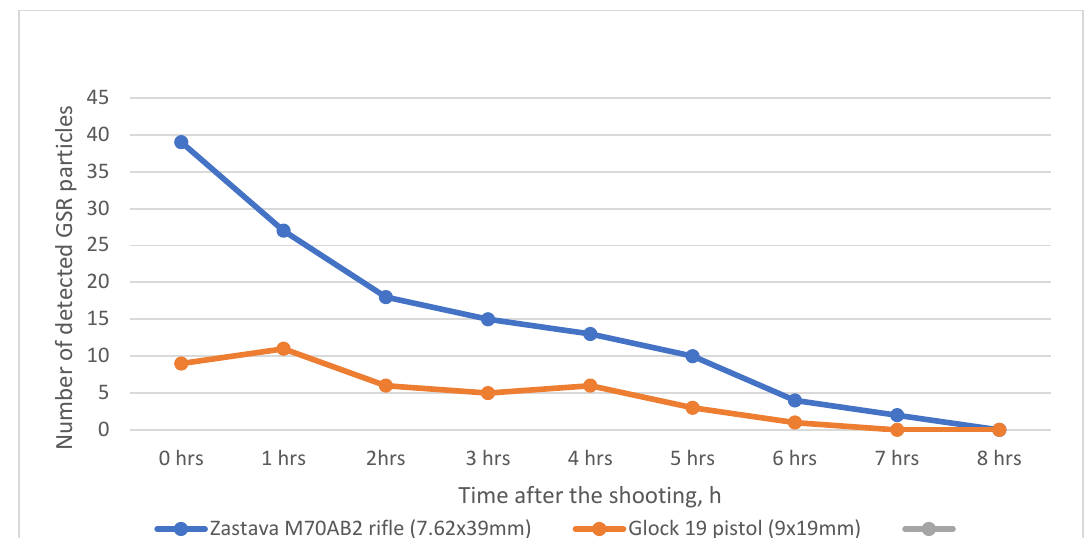
Figure 6. Number of particles characteristic of GSR as a function of time after discharge of a high ‐ caliber Zastava M70AB2 rifle (blue line) and a low ‐ caliber Glock 19 pistol (9 × 19 mm) (orange line).